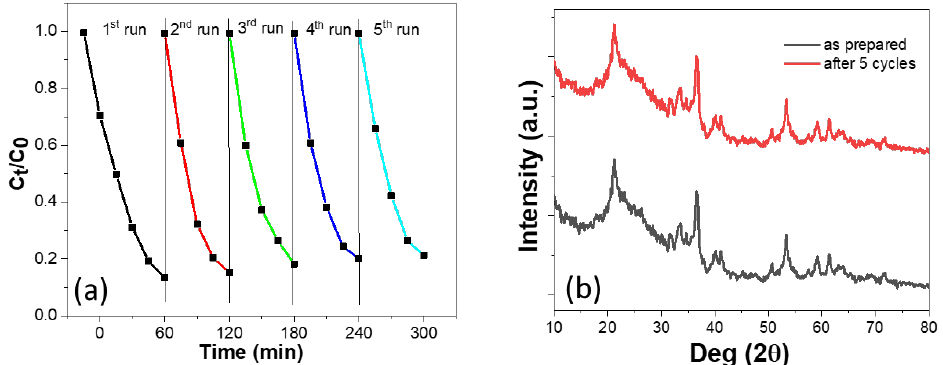
Figure 6. ( a ) Reusability study for 5 cycles of the FeOOH/C composite and ( b ) the pre- and post-run XRD of the FeOOH/C